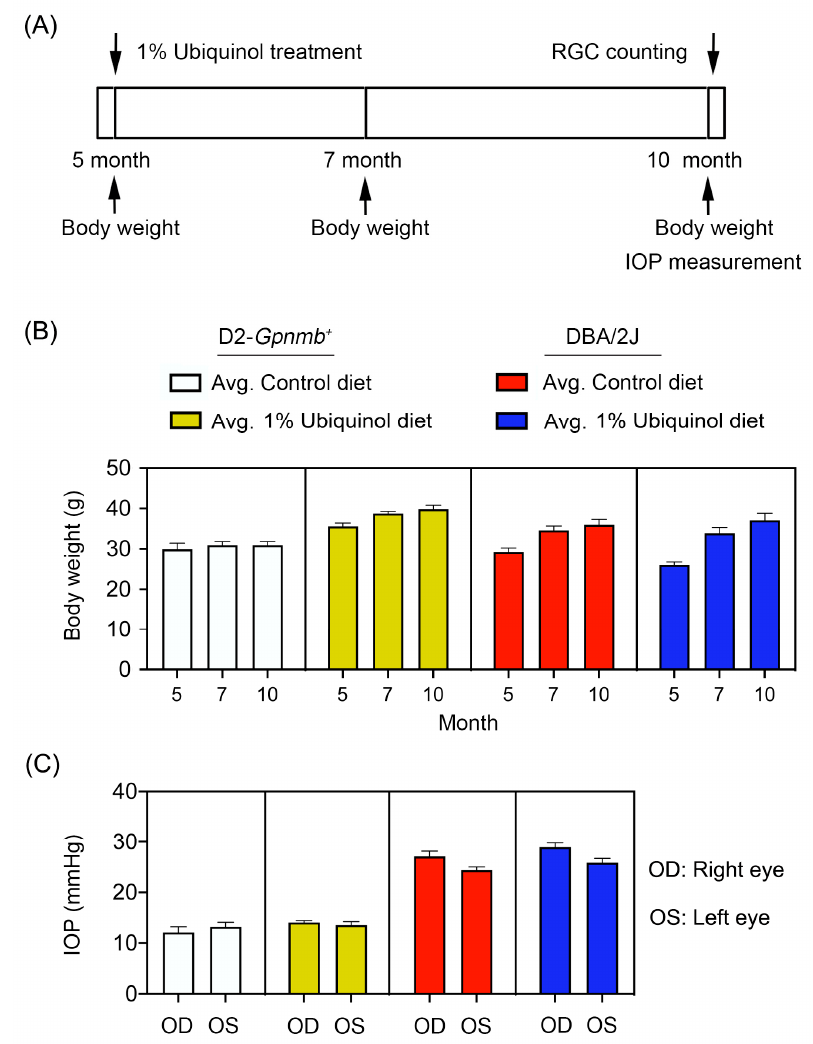
Figure 1. Ubiquinol supplementation and intraocular pressure (IOP) measurement in glaucomatous DBA/2J mice. ( A ) Diagram for control and ubiquinol diet (1%) supplementation and measurements for body weight, IOP and retinal ganglion cell ( RGC) survival. Preglaucomatous DBA/2J and age- body weight, IOP and retinal ganglion cell (RGC) survival. Preglaucomatous DBA